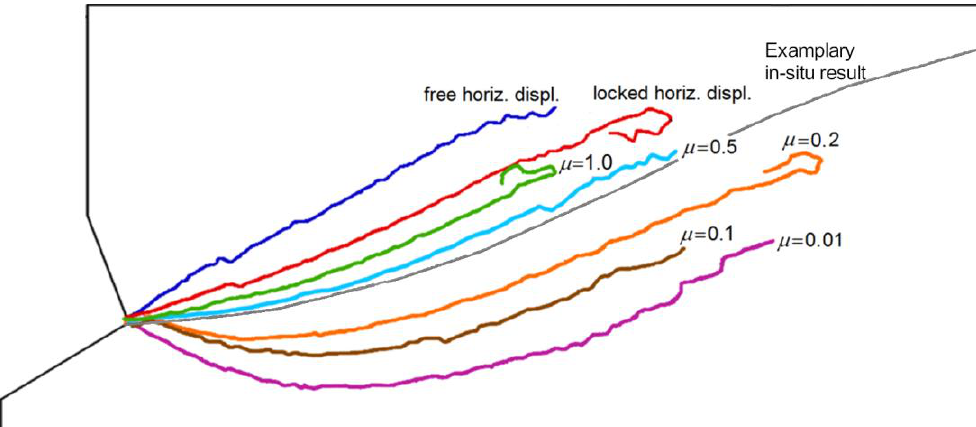
Figure 12: Crack paths for different methods of applying the load.